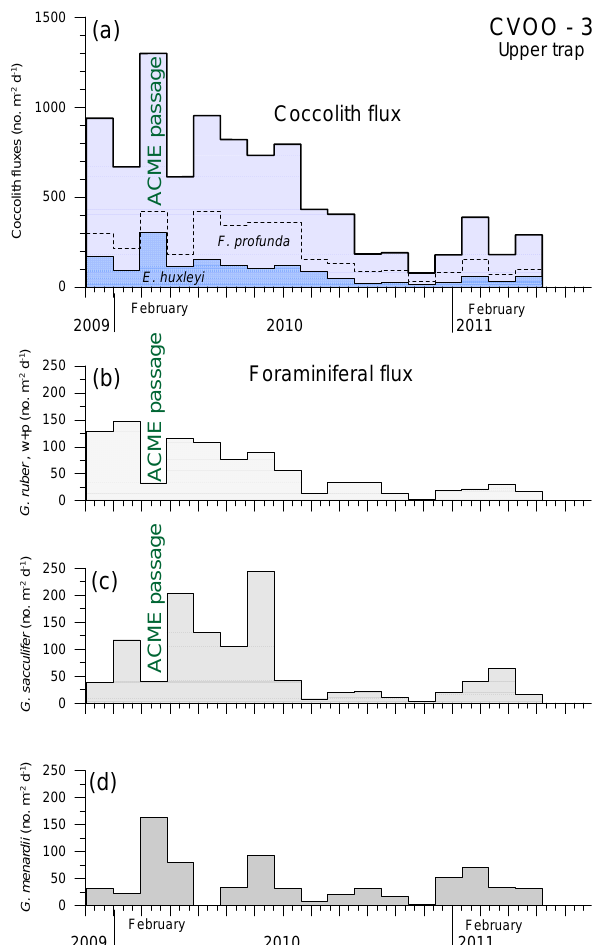
Figure 8. Upper trap fluxes of major primary and secondary car- bonate producing organisms (Table 2). (a) Coccolithophores (total coccolith flux, flux of E. huxleyi and F. profunda ). The planktonic foraminifera (b) G. ruber (white and pink), (c) G. sacculifer and (d) the deep-dwelling G. menardii , the latter showing a distinct peak in flux during the ACME passage in February